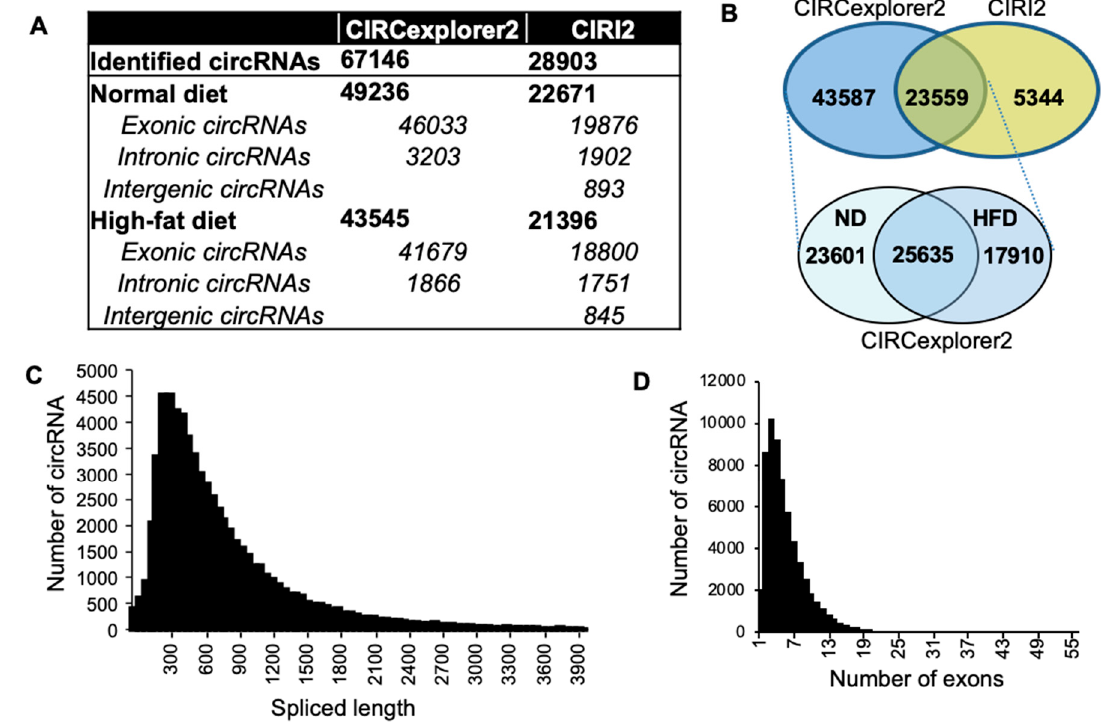
Figure 1. Annotation and characteristics of circular RNAs (circRNAs) in mouse pancreatic islets. ( A ) Summary of circRNAs identified in pancreatic islets of mice fed with normal diet (ND) and high-fat diet (HFD), using CIRCexplorer2 and CIRI2. ( B ) Venn diagram showing the overlapped circRNAs detected in pancreatic islets using CIRI2 and CIRCexplorer2 ( top ). Venn diagram of circRNAs detected by CIRCexplorer2 in pancreatic islets of mice fed with ND or HFD ( bottom ). ( C ) Distribution of the spliced length of circRNAs with length up to 4000 nucleotides in pancreatic islets detected by CIRCexplorer2. ( D ) The exon number distribution for exonic circRNAs detected with CIRCexplorer2.